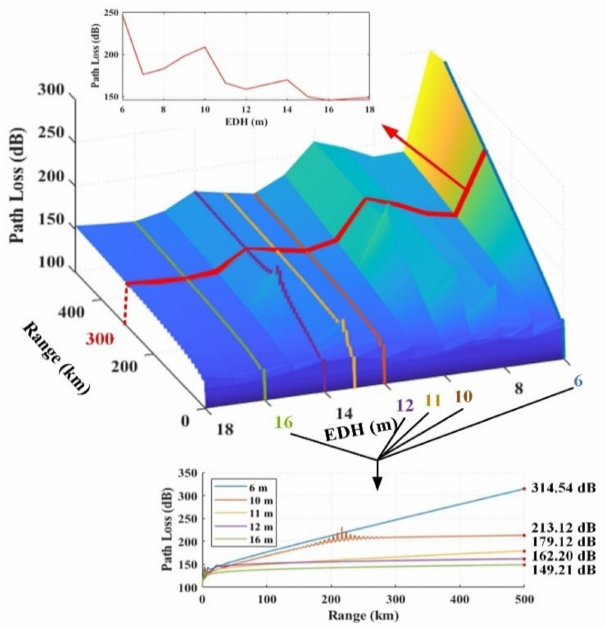
Figure 1. The transmission loss diagram at 12 GHz with a distance of 0–500